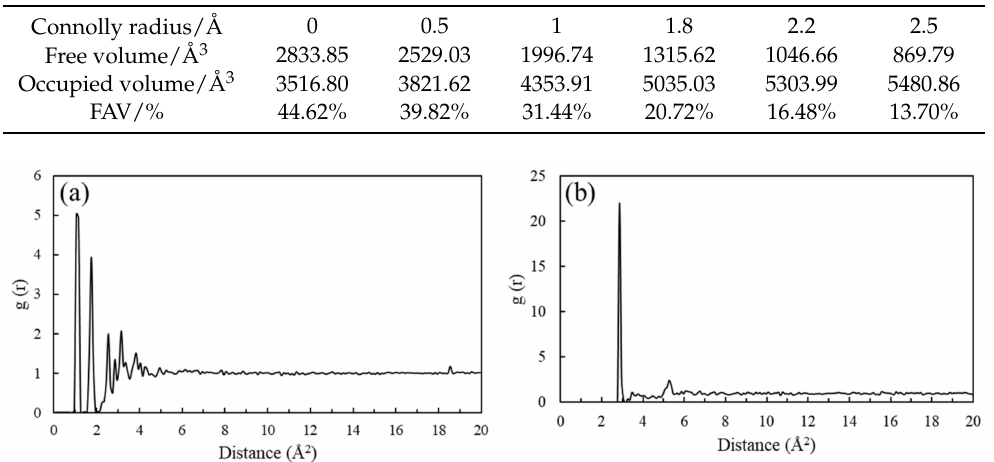
Figure 3. ( a ) RDF of all the atoms of the PDMS membrane and ( b ) RDF between Si atoms on the main chain and C atoms on the branch